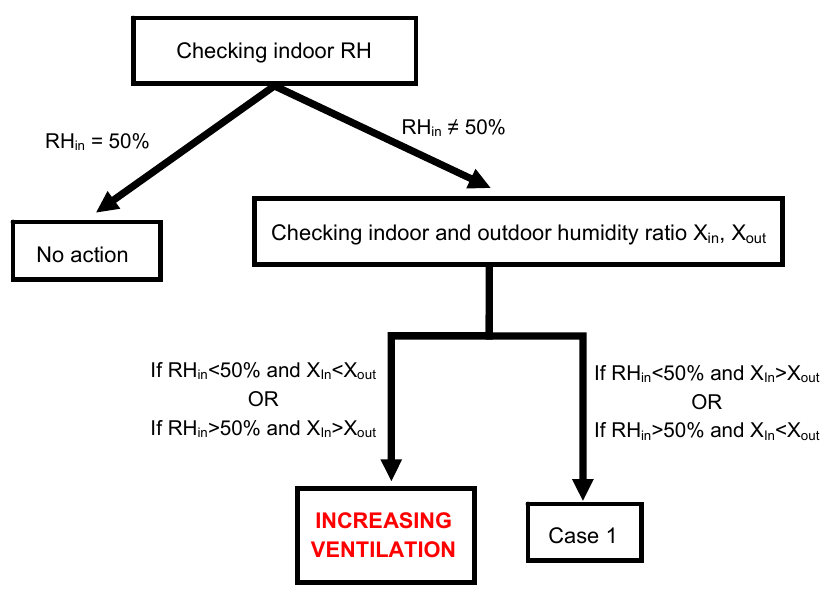
Figure 5. Operation scheme for control of the relative humidity as explained in case 3.